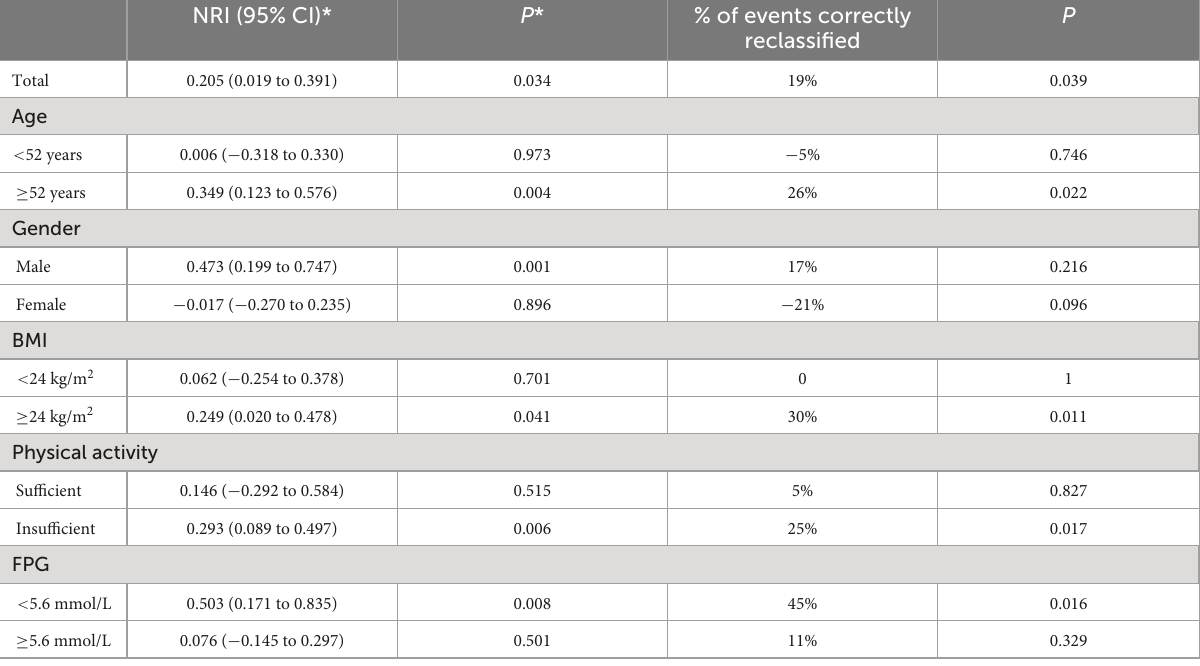
TABLE 6 Reclassification of type 2 diabetes risk after addition of serum 25(OH)D to conventional risk